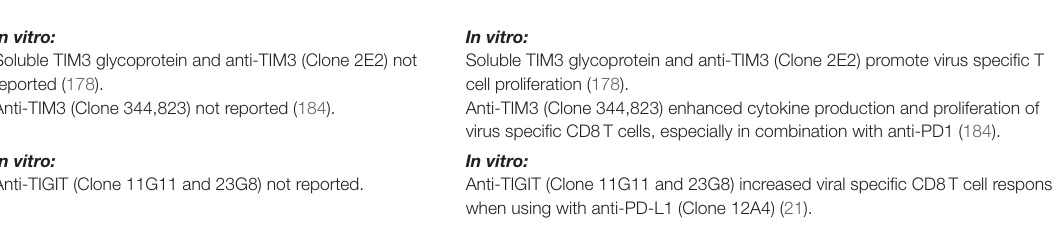
Frontiers in Immunology |